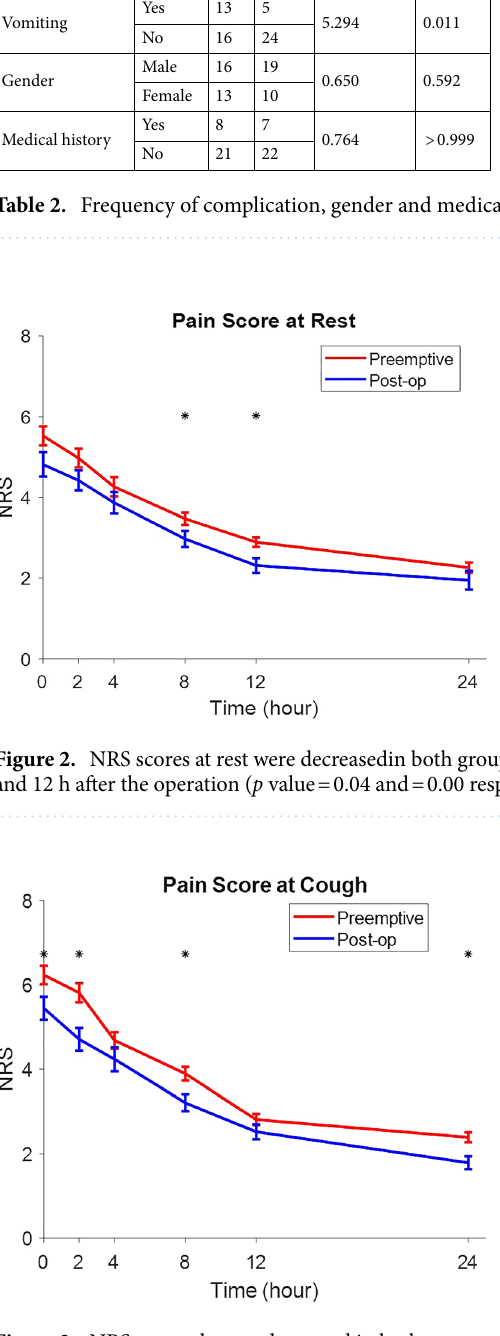
Figure 3. NRS at cough were decreased in both groups over time, which were statistically significant during the recovery at 2, 8, 12 h after the operation ( p value = 0.027, p value = 0.002, p value = 0.009, and p value = 0.002,